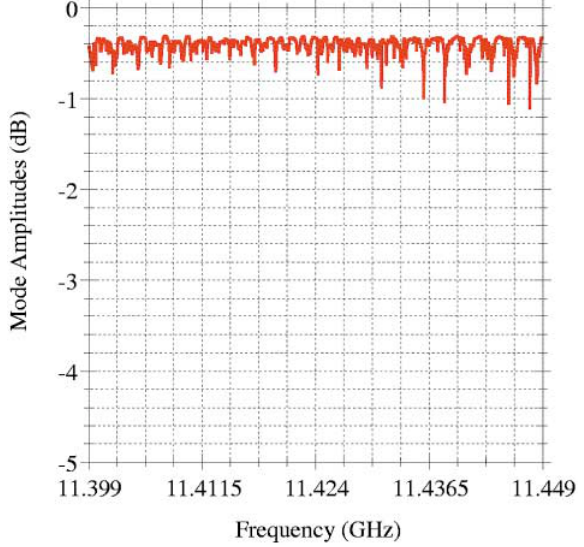
FIG. 23. (Color) Transmission through two TE 12 mode trans- ducers, two arc tapers, and 55 m of 12.065 cm diameter circular waveguide. 082001-18